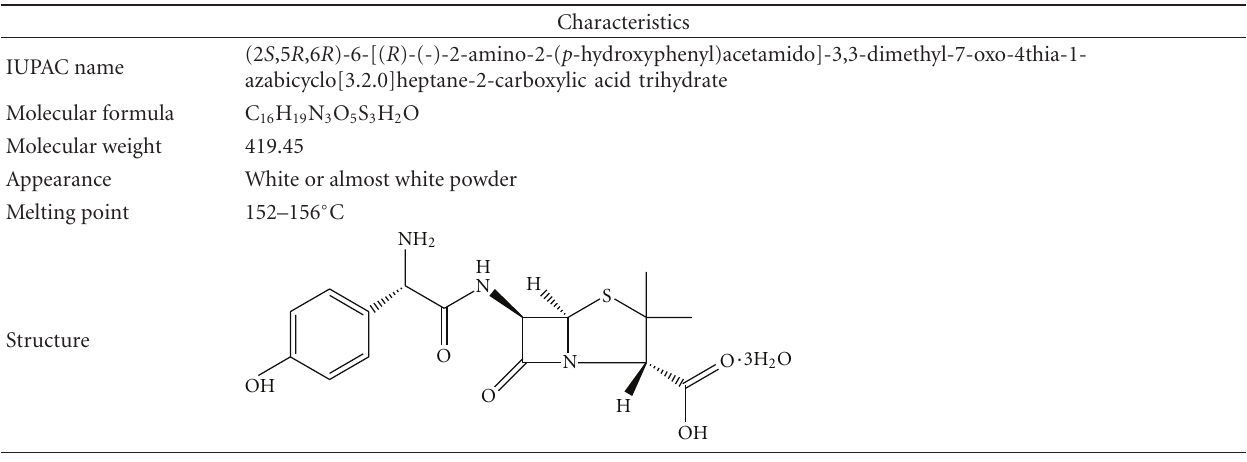
Table 1: Chemical structure and characteristics of AMOX.